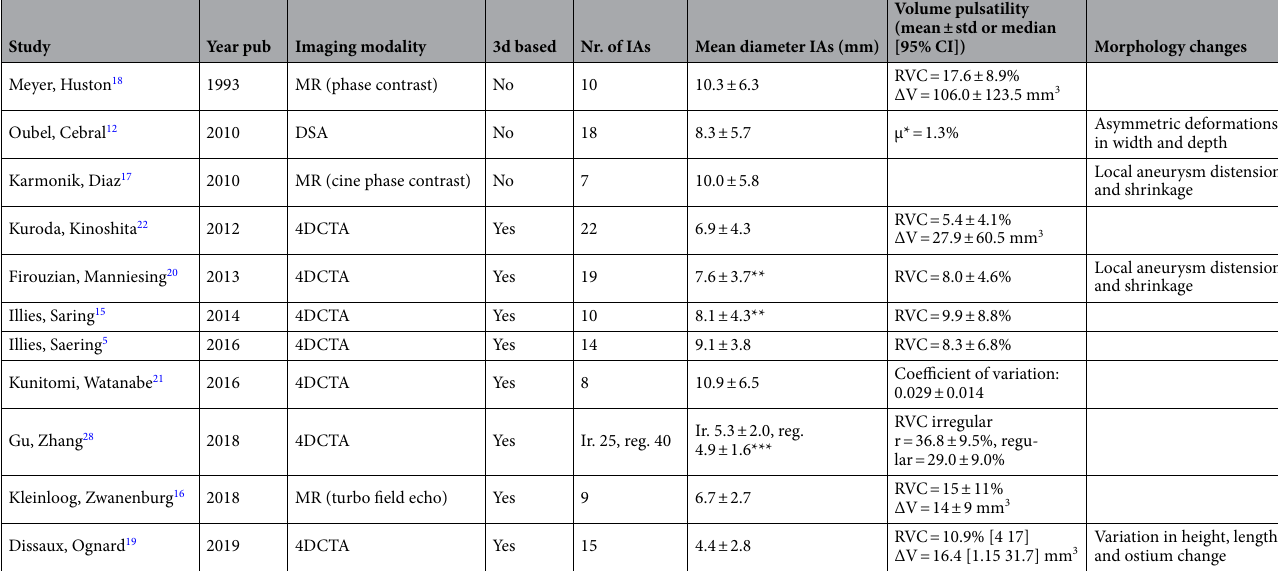
Table 1. Summary of findings. Magnetic Resonance (MR), Digital Subtraction Angiography (DSA), 4D Computed Tomography Angiography (4D CTA), RVC = (Vmax − Vmin)/Vmin * 100%, ΔV = Vmax-Vmin, **Differential pulsation (μ) is the maximal change in IA depth or width, corrected for the artery diameter and the relative artery diameter change. **Max diameter instead of mean. ***Irregular shaped and regular shaped IAs were reported separately.